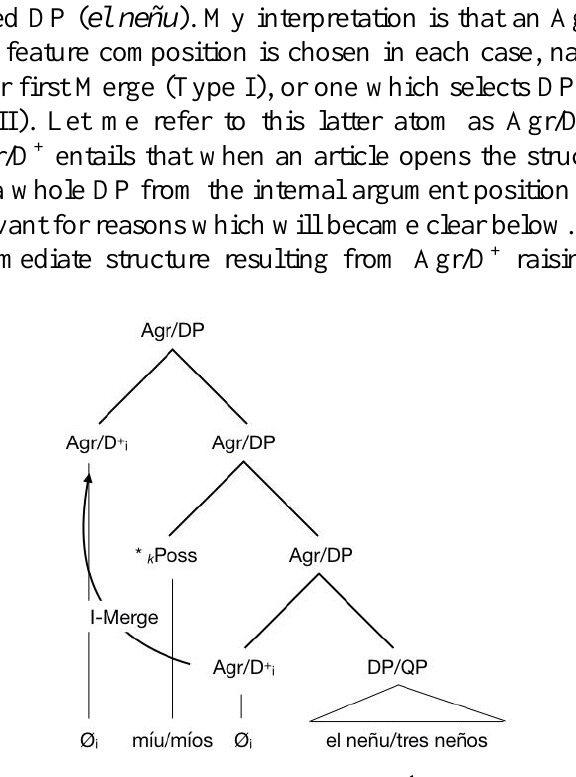
Figure 5. Postnominal possessive construction (Type III: e.g. el neñu míu ). Intermediate